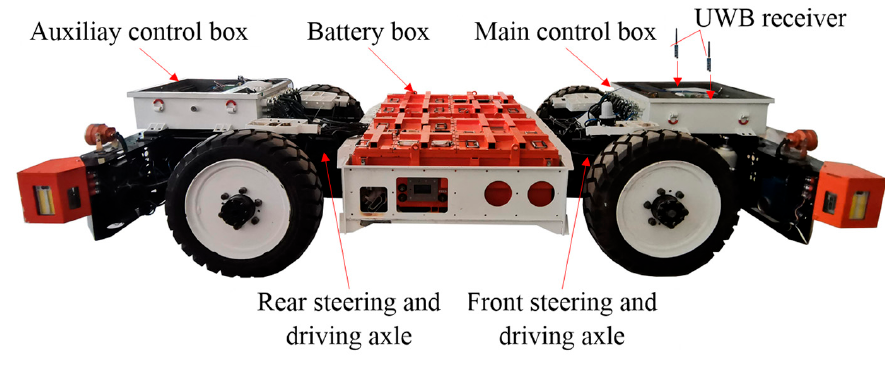
Figure 3. Test vehicle assembly. Table 1. Technical parameters of WLR-5A mining wheeled unmanned chassis.